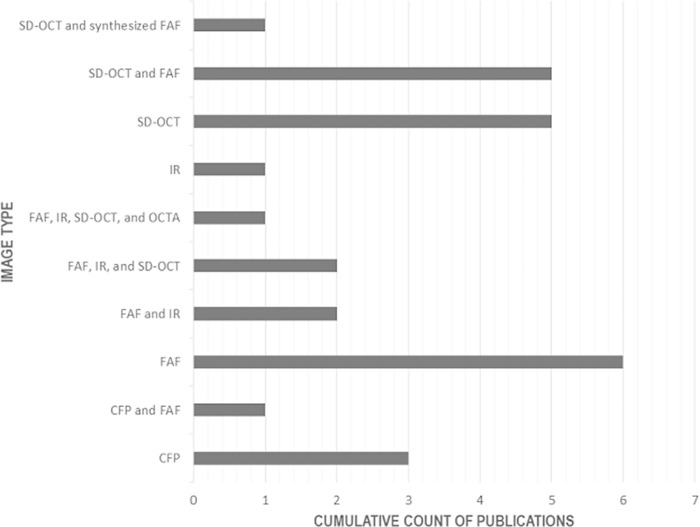
Imaging modalities used in GA-AI studies. FAF only images were the most commonly used image modality among GA-AI studies (n = 6). A combination of SD-OCT and FAF imaging (n = 5) and SD-OCT only (n = 5) were the second most commonly used imaging types in GA-AI studies, followed by CFP only (n = 3). AI, artificial intelligence; GA, geographic atrophy; CFP, color fundus photograph; FAF, fundus autofluorescence; IR, near-infrared; SD-OCT, spectral domain optical coherence tomography; OCTA, optical coherence tomography angiography.